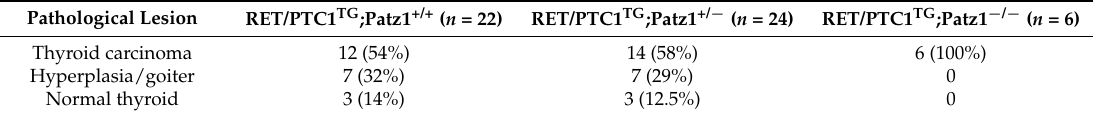
Table 1. Histopathological diagnosis of tumors developed by RET/PTC1-Patz1 mice at 10–17 months of